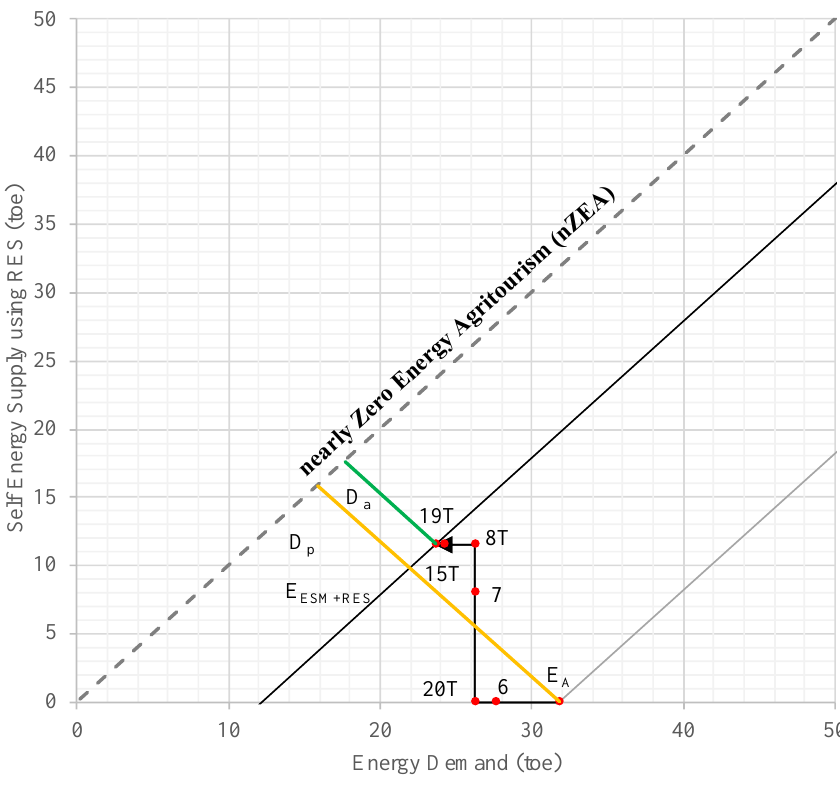
Figure 5. Path towards a nearly zero energy condition (nZEA) for Bergi.